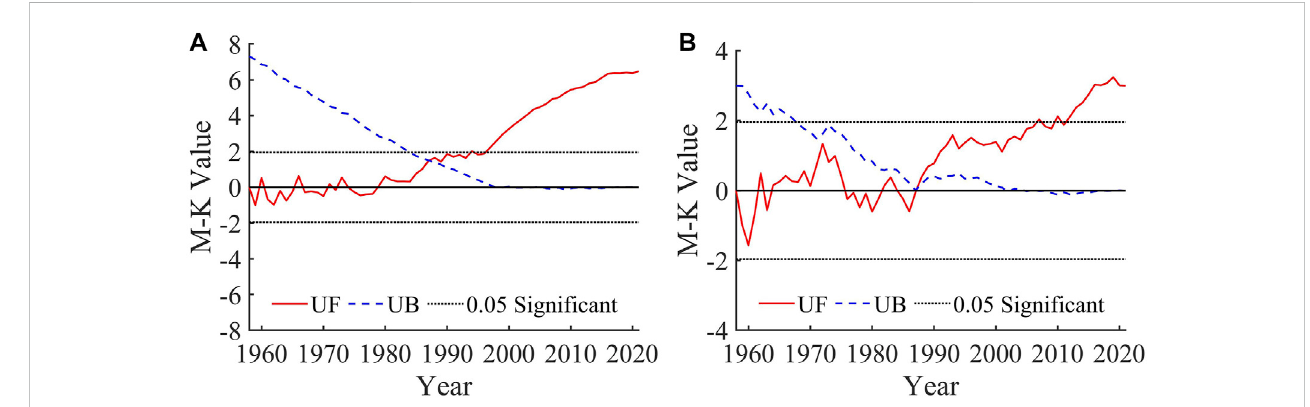
FIGURE 5 Analysis results of the abrupt changes in the temperature and precipitation in the basin. (A) Temperature. (B) Precipitation.